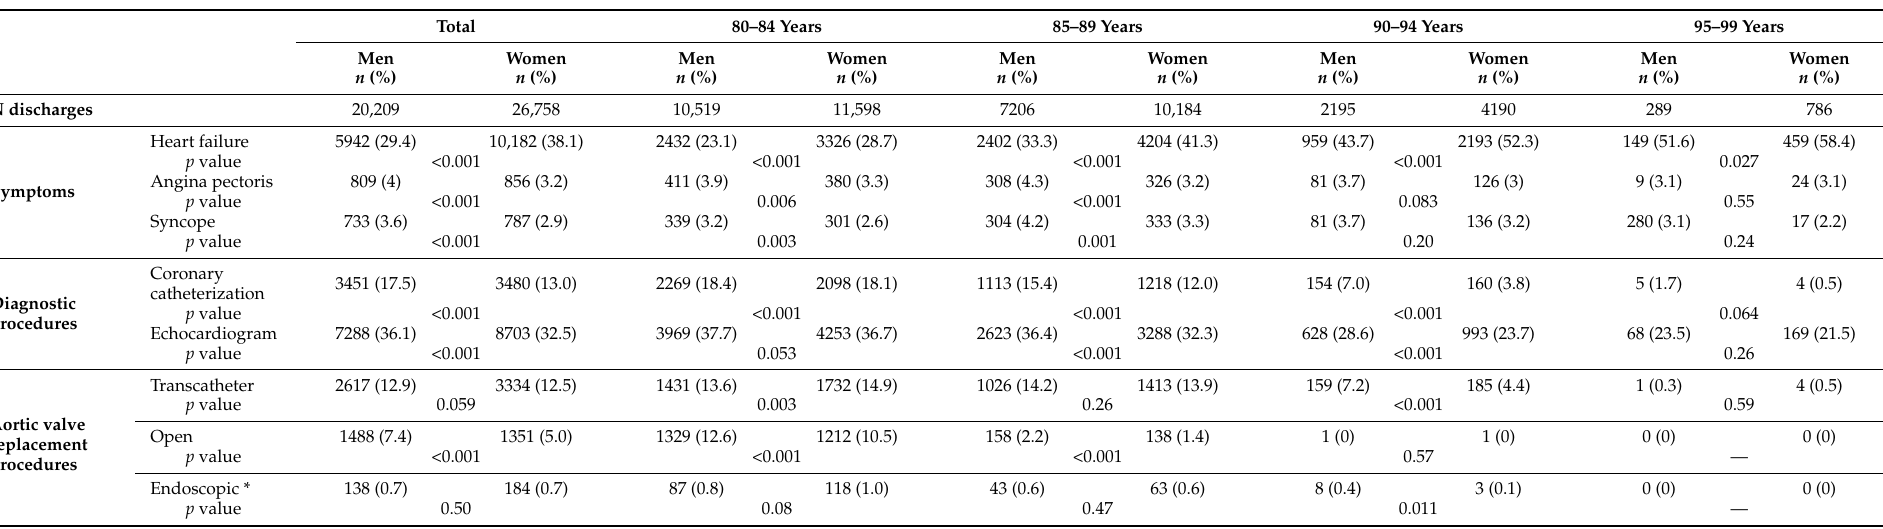
Table 4. Symptoms, diagnostic procedures, and therapeutic approach related to aortic stenosis by sex and age